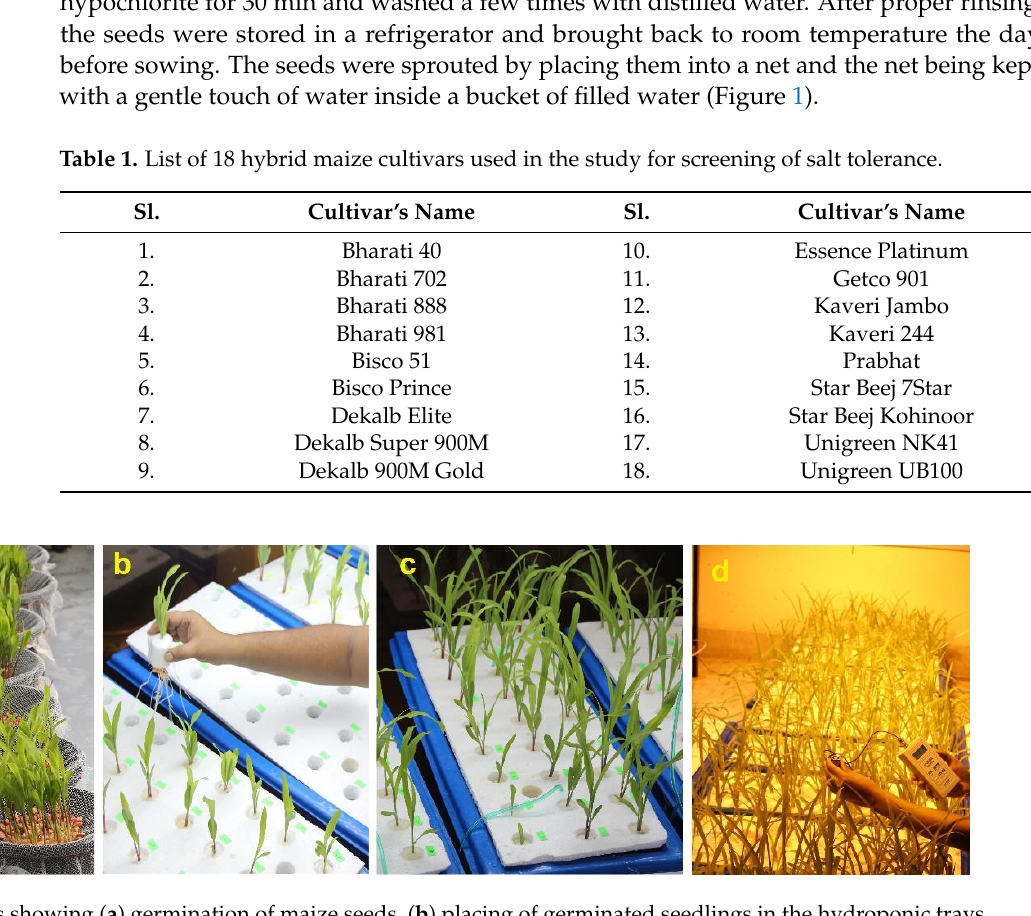
Figure 1. Photographs showing ( a ) germination of maize seeds, ( b ) placing of germinated seedlings in the hydroponic trays, ( c ) seedling growth in the hydroponic system and ( d ) light intensity measurements inside the growth chamber.